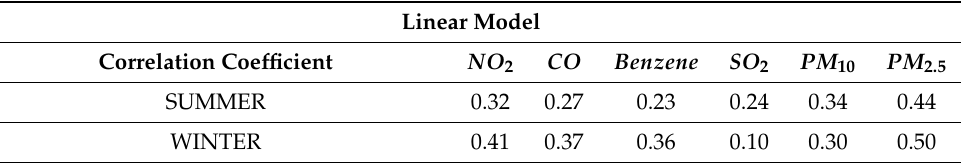
Table 4. Correlation coefficients for all air quality features for both the summer and winter seasons for the linear model.